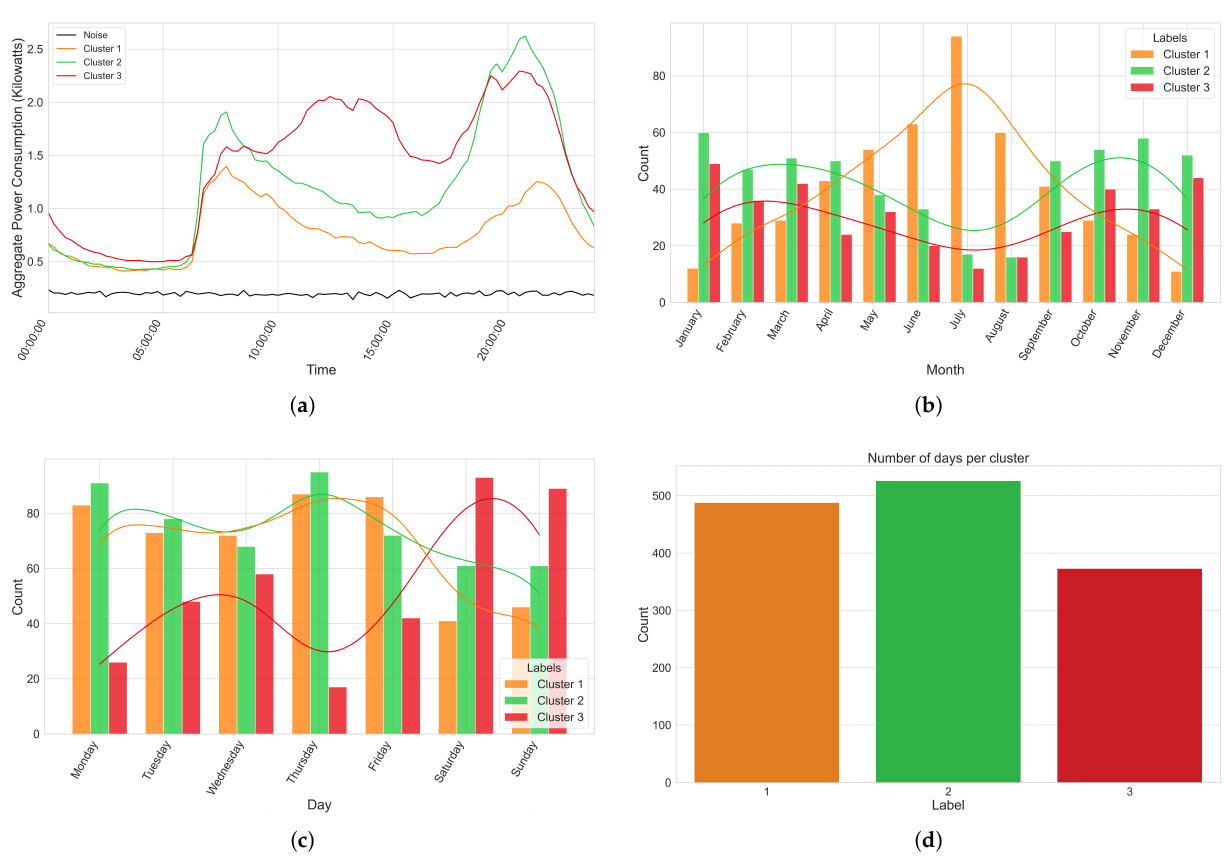
Figure 18. Visualization of the generated clusters. ( a ) Average power consumption per hour of the day for each of the resulting clusters obtained after utilizing the HDBSCAN algorithm on our 2-dimensional representation of the UCID dataset. ( b ) Distribution of the clusters over the different months of the year. ( c ) Distribution of the clusters over the different days of the week. ( d ) Spread of the number of samples per cluster